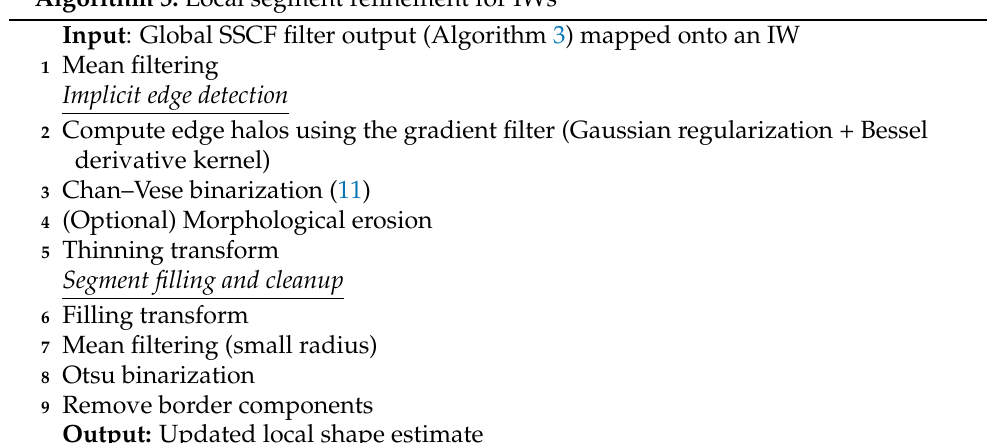
Algorithm 5: Local segment refinement for